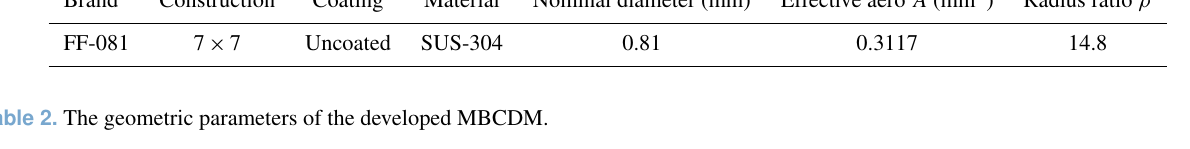
Figure 4. Shape and configuration of the MBCDM: (a) overall shape; (b) detailed view. Table 1. The physical properties of the selected cable. Brand Construction Coating Material